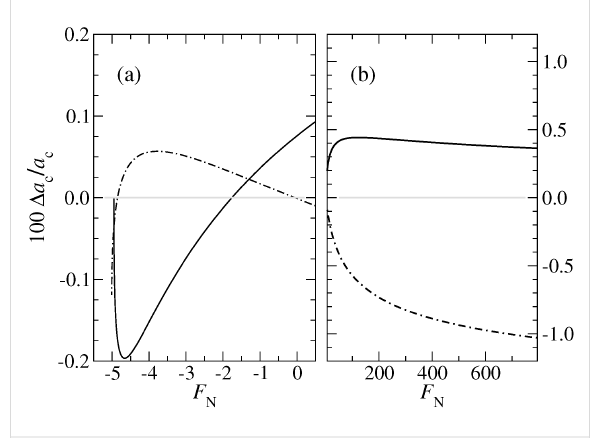
Figure 13: Relative errors in per cent for the contact radius a c for μ T = 1 at (a) negative and (b) positive load. The full line indicates the error when using Equation 48, while the dot-dashed line is based on Equation 47. In both cases, the parameter α ( μ T ) was adjusted to mini- mize the deviation from Maugis solution in the domain − F p < F N < 2 F p .